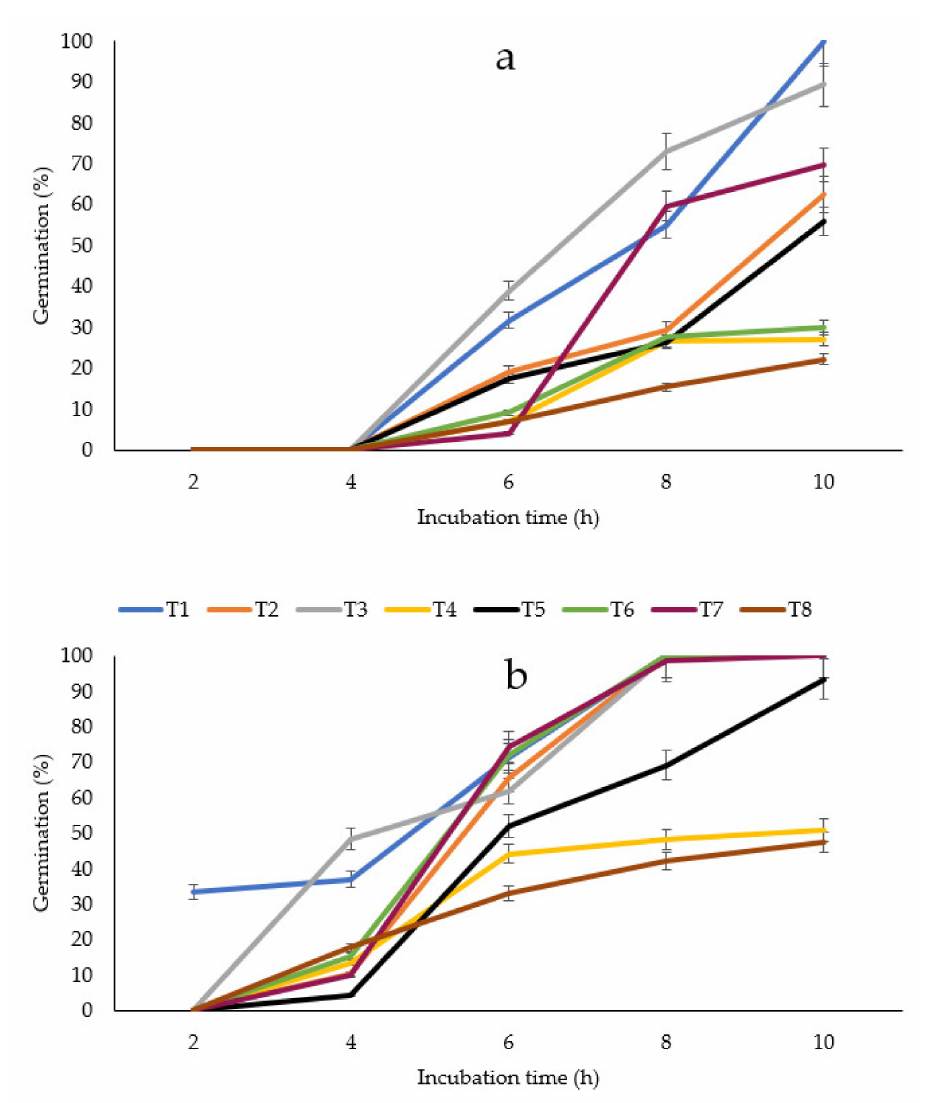
Figure 1. Conidial germination of ( a ) Colletotrichum gloeosporioides and ( b ) Rhizopus stolonifer incubated in the presence of nets manufactured with 60/40 PLA/PPBAT + PEO at different concentrations and 1% chitosan for 10 h at 20 ◦ C. Bars indicate the standard error of the mean. (See Table 4 for treatments